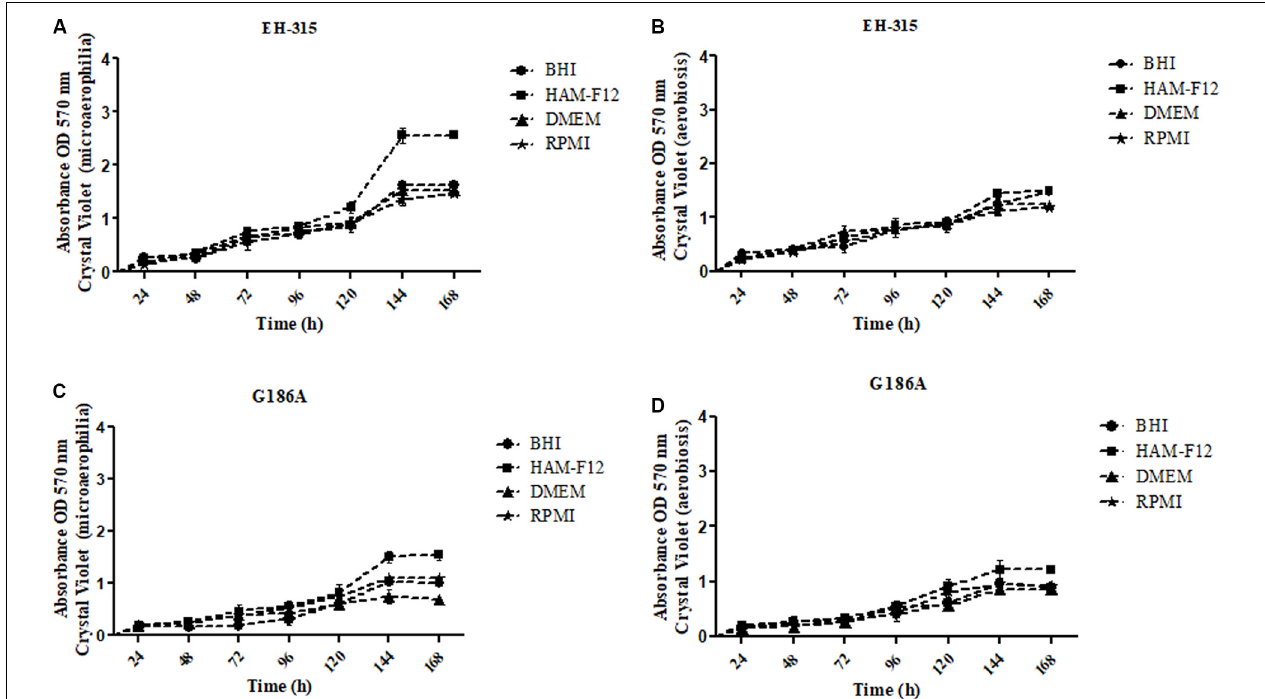
FIGURE 3 | Kinetics of the biomasses formed by different strains of H. capsulatum (A,B) EH-315 and (C,D) G186A in microaerophilia (A–C) and aerobiosis (B–D) conditions.